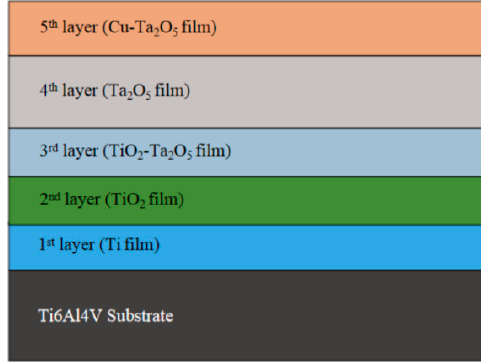
Figure 1. Scheme of Cu-MTa 2 O 5 multilayer composite coatings.